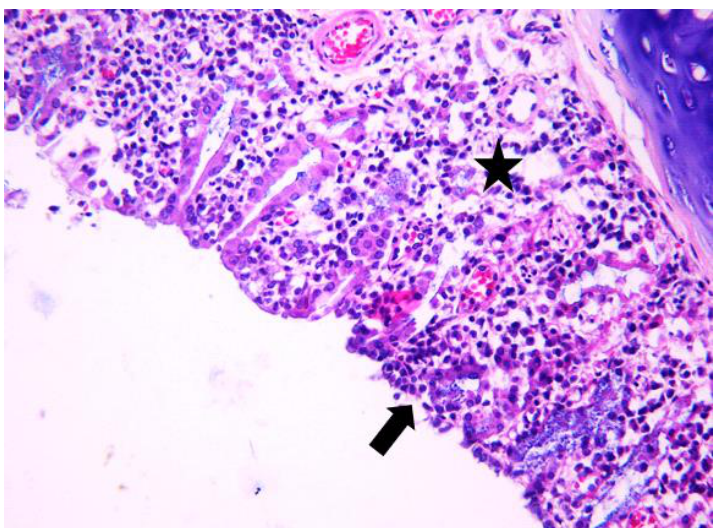
Figure 4. Light micrographs of the rat’s nasal septum, control group, at 14 days after the intranasal intervention. Diffuse infiltration of the lamina propria of the mucosa covering the nasal septum by many lymphocytes admixed with macrophages and few plasma cells (black star). The covering mucosa is occasionally erosive (arrow); H&E, ob ×40.